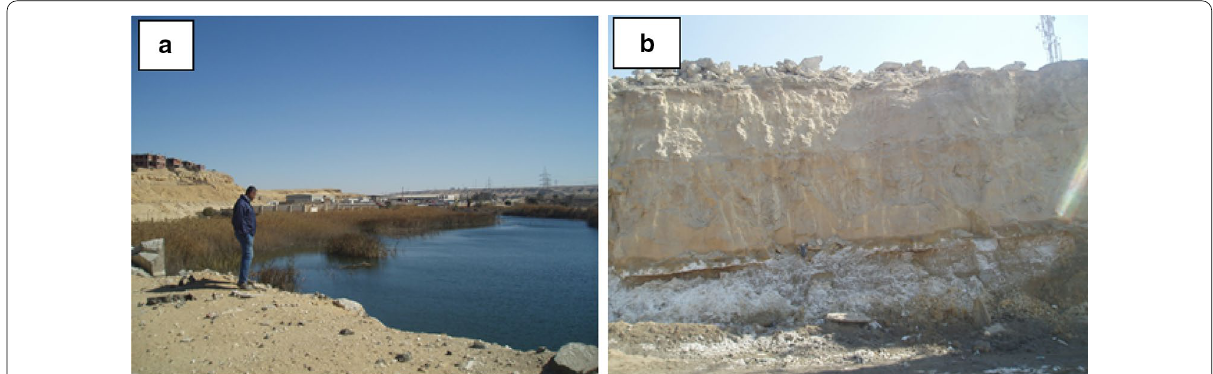
Fig. 11 Field photographs showing a wastewater pond in Wadi Degla area from the seepage of land uses upstream and the impact of seepage on waterlogging and salt weathering in the outcrops in the study area ( a , b , respectively)